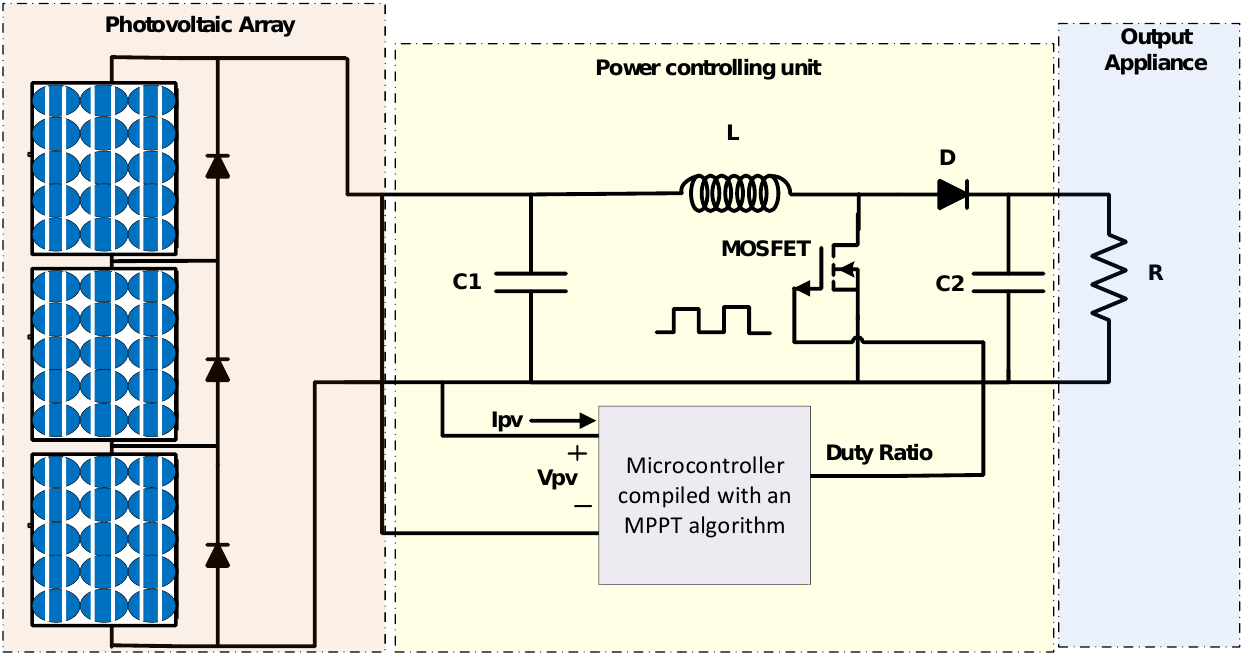
Figure 2. MPPT controller. The PV generates power, which is adjusted by the power-controlling unit to send the maximum power at the